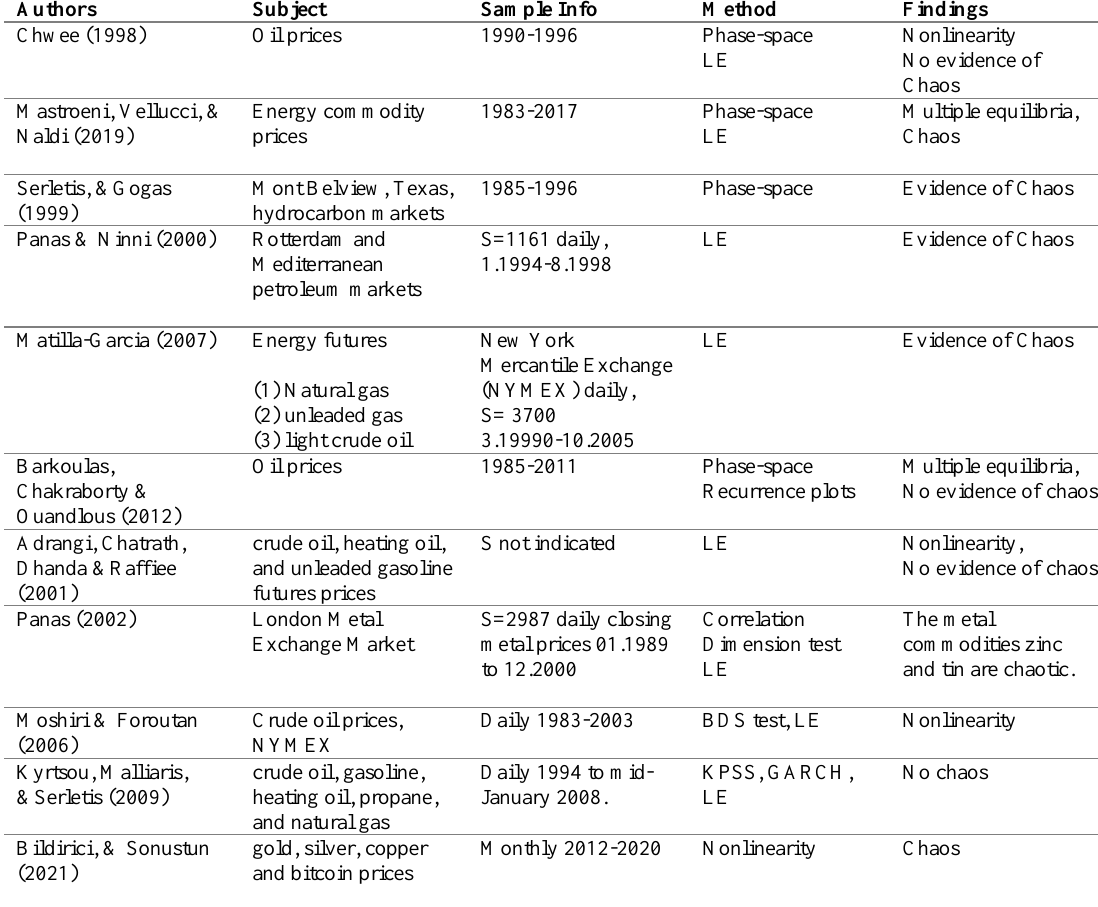
Table 1: Summary of Literature